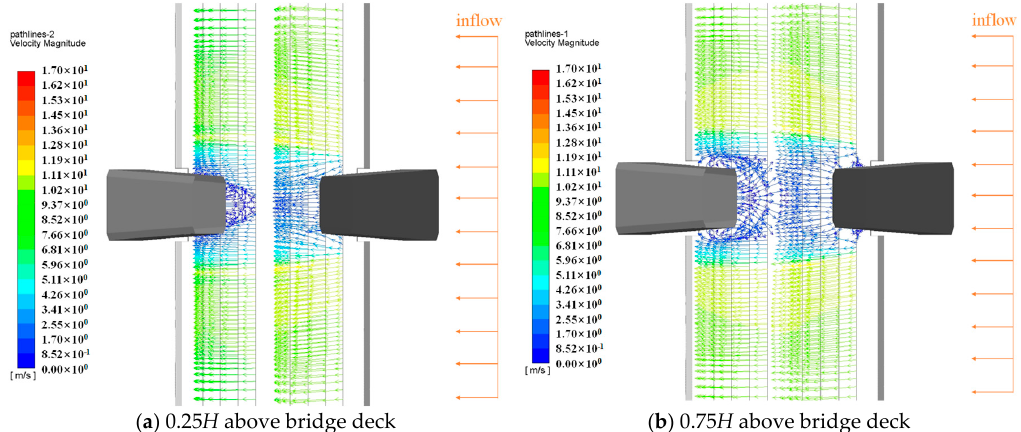
Figure 10. Numerical simulation results (C2 condition).